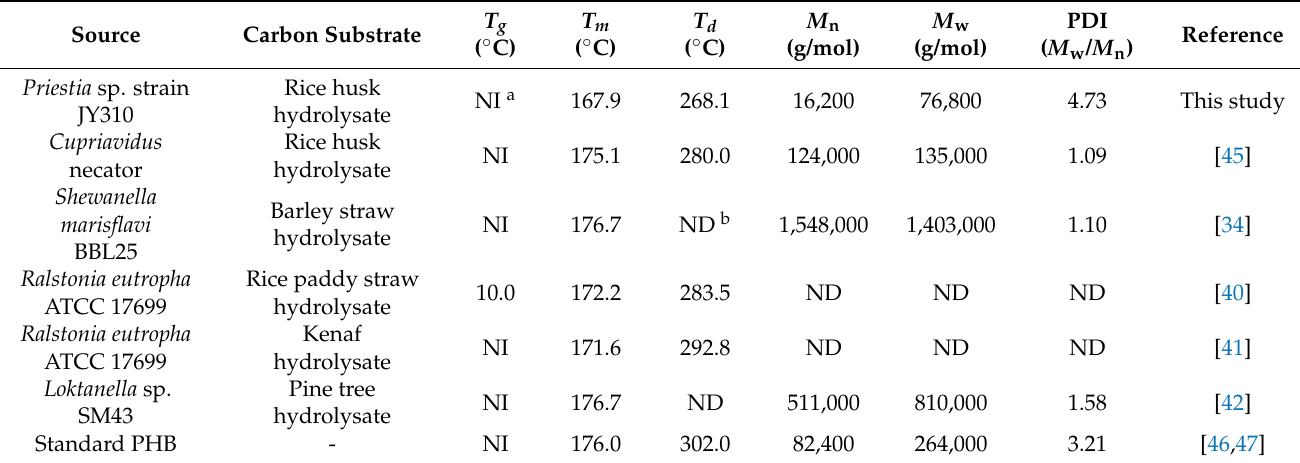
Figure 8. TG/DTA thermogram of PHB biosynthesized by Priestia sp. strain JY310 under nitrogen atmosphere.